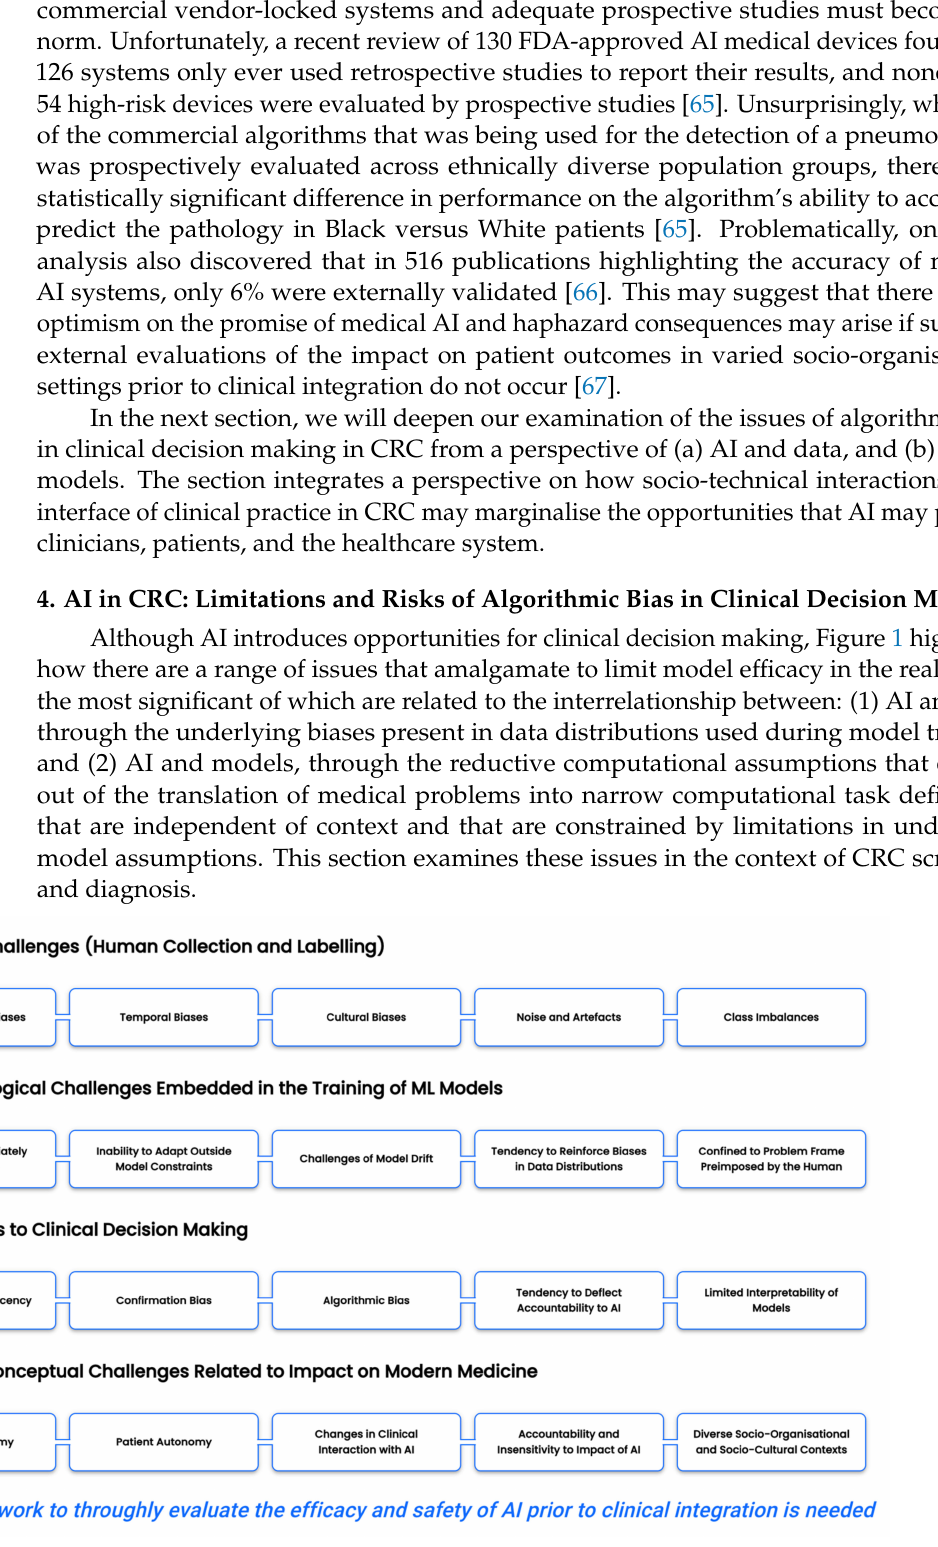
Figure 1. This infographic highlights the range of potential challenges associated with AI in clinical decision making and reinforces the need for a robust framework to AI evaluation prior to clinical integration, to maximise confidence in the safety and equity of system use in